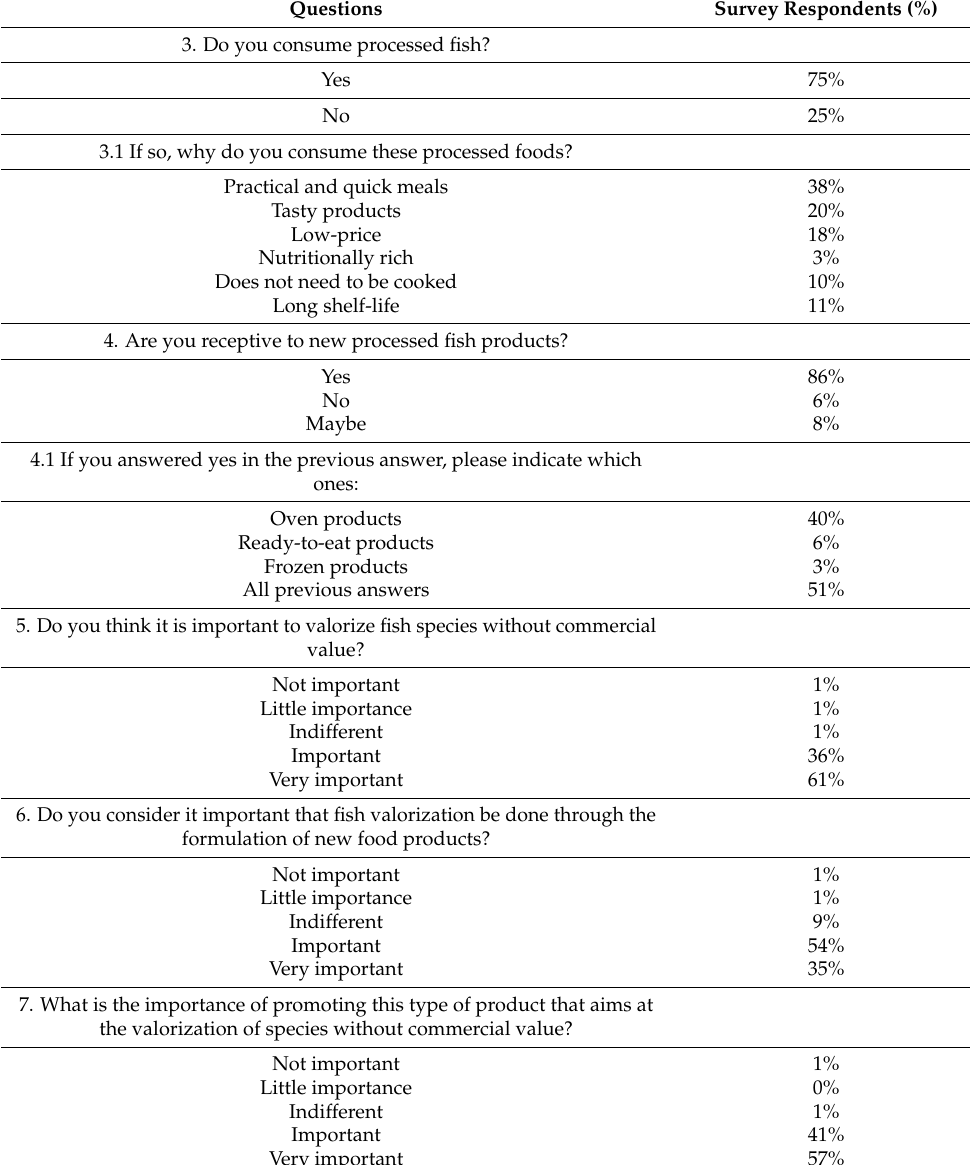
Table 3. Results of the survey concerning consumers’ consumption habits of processed fish products ( n = 155), the reason for their consumption ( n = 117), their receptivity to these products’ innovation ( n = 155), what type of innovative products the consumer would like ( n = 124), the significance of fish species valorization ( n = 155), and the importance of new product formulation with their inclusion and promotion ( n =